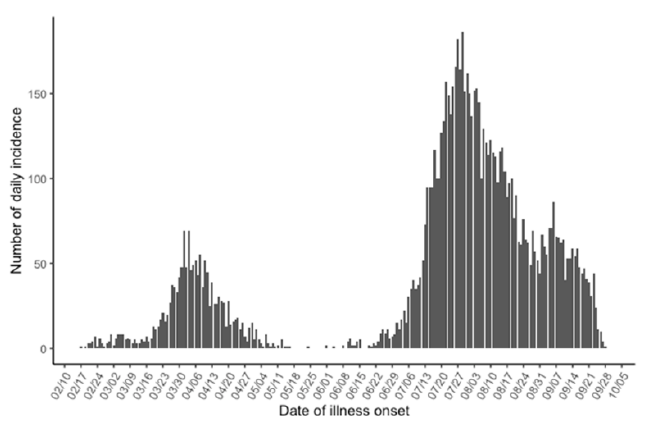
Figure 1. Daily numbers of new coronavirus disease 2019 (COVID-19) cases in Osaka prefecture from 17 February to 28 September 2020. Cases were counted as a function of the date of illness onset.